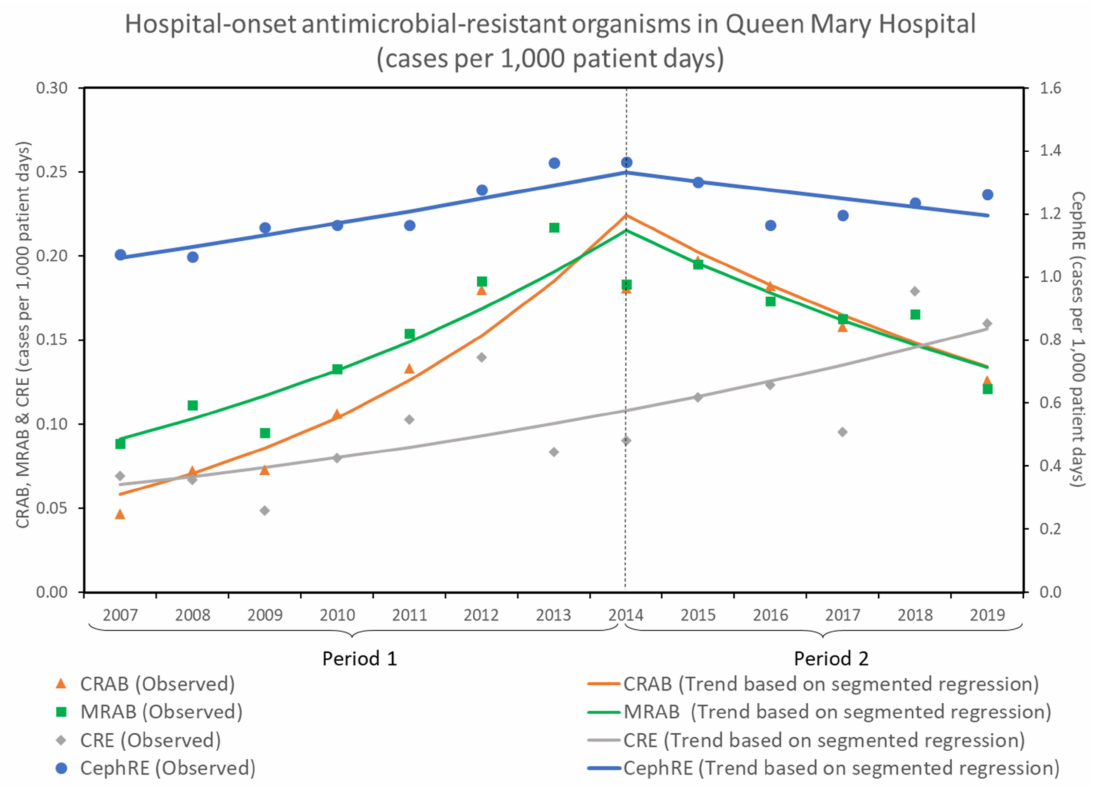
Figure 3. Hospital-onset antimicrobial-resistant organisms in Queen Mary Hospital from 2007 to 2019. CRAB, carbapenem-resistant Acinetobacter baumannii ; CephRE, cephalosporin-resistant Enter- obacterales; CRE, carbapenem-resistant Enterobacterales; MRAB, multidrug-resistant Acinetobacter baumannii